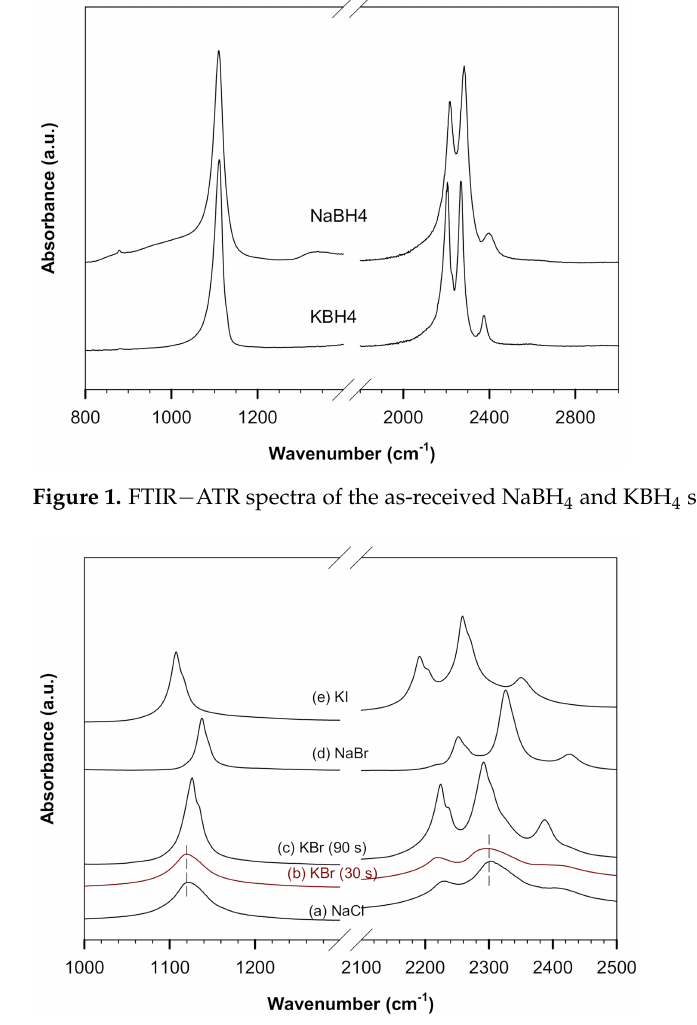
Figure 2. Room temperature transmission IR spectra of as − received NaBH 4 in NaCl ( a ), in KBr short pressed ( b ) and long pressed ( c ), in NaBr ( d ) and in KI ( e ). Vertical dashed lines are used to show the coincidence of peak positions of ν 4 and ν 3 of ( a , b